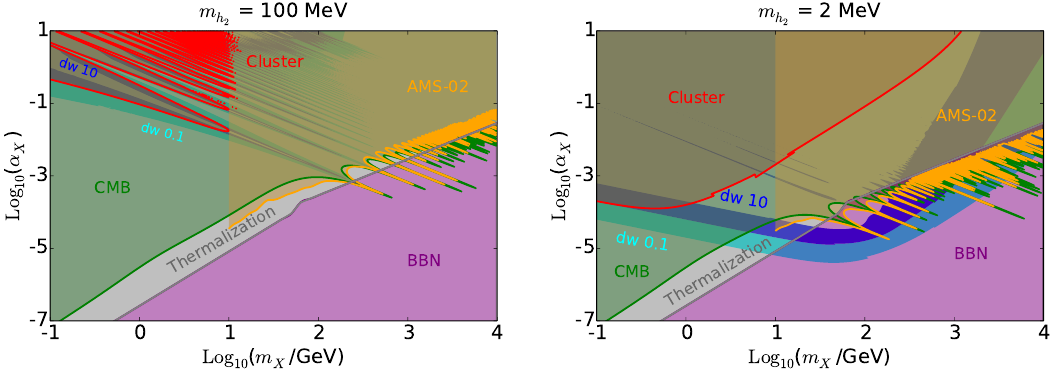
Figure 7 . Region (i) in the parameter space with m h = 100 MeV (left panel) and m h = 2 MeV 2 2 (right panel) for which the VDM self scattering might be su(cid:14)ciently strong to solve the small scale structure anomalies. The numbers next to \dw" represent (cid:27) T =m X in units of cm 2 =g at the dwarf scale. The blue (cyan) region shows the space with the VDM self-interaction cross section of 1 cm 2 = g < (cid:27) T =m X < 10 cm 2 = g (0 : 1 cm 2 = g < (cid:27) T =m X < 1 cm 2 = g) at the dwarf scale, while the red region shows bounds on VDM self scatterings at the cluster scale. The purple, green, and orange colors show regions excluded by the DM indirect searches from BBN, CMB, and AMS-02, respectively. The region below the curve named \Thermalization" shows the parameter space in which the VDM is generated via freeze-in, and the gray region above the curve corresponds to the one with dark sector thermalized in itself. In both plots the Higgs portal coupling (cid:20) is (cid:12)xed by the VDM relic density as a function of m X in the freeze-in